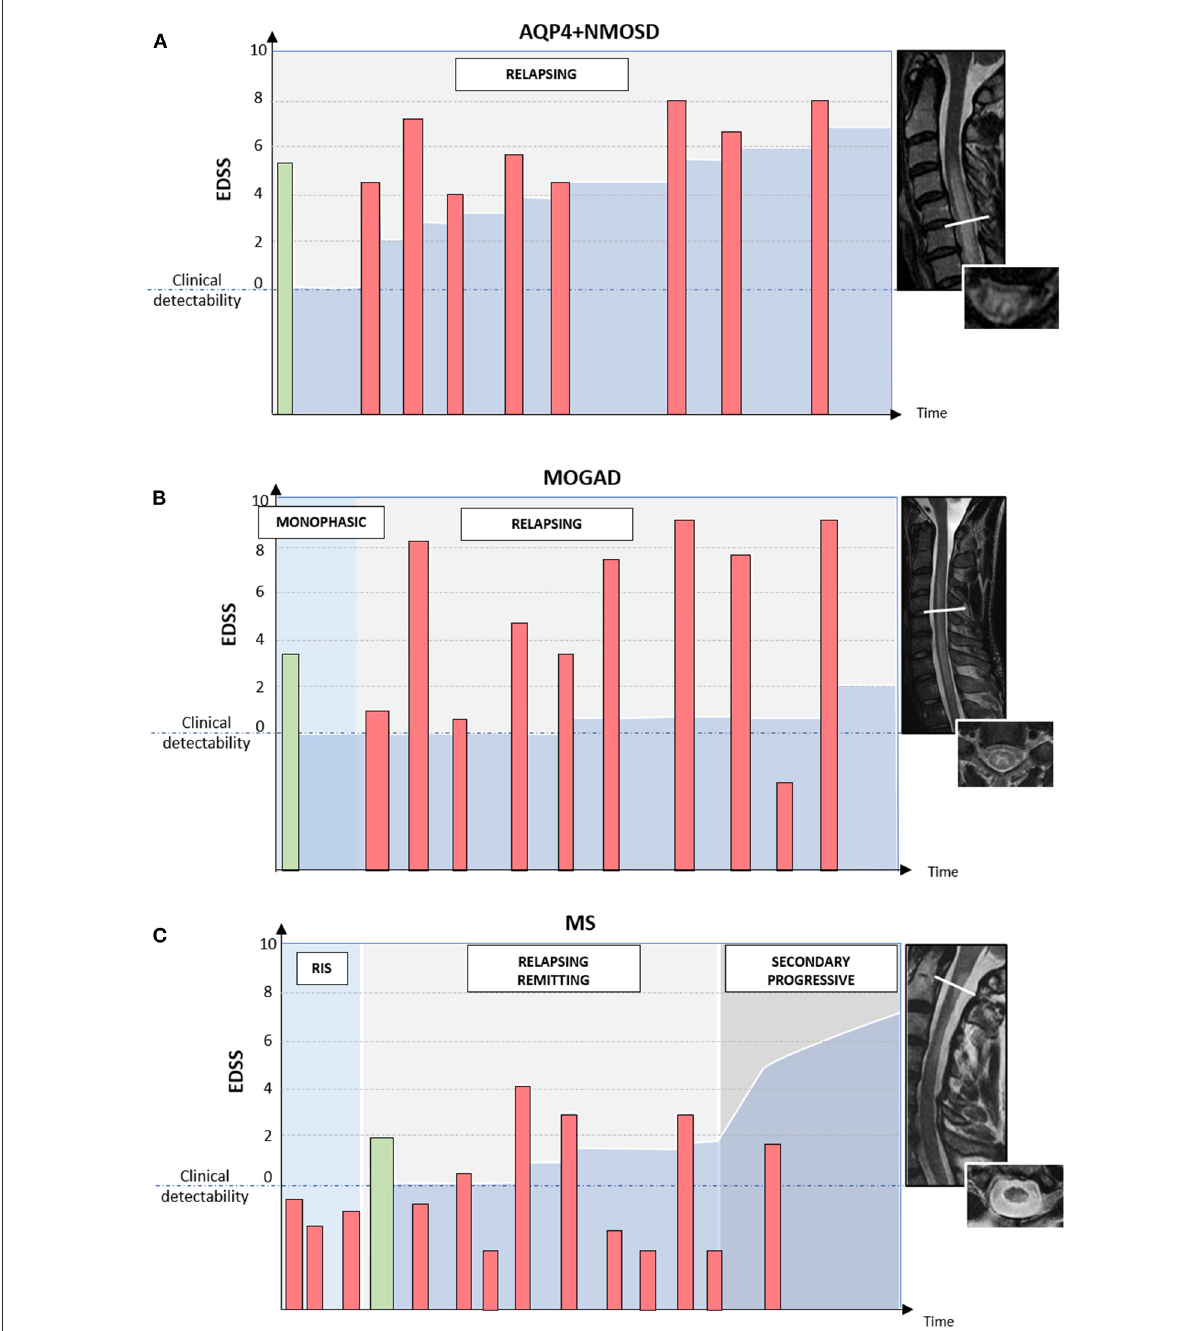
FIGURE4 Different disease courses and patterns of disability accrual in AQP4-IgG-positive neuromyelitis optica spectrum disorder (AQP4 + NMOSD), MOG-IgG-associated disease (MOGAD), and multiple sclerosis (MS). Red bars = disease relapses; green bars = first clinical attack; darker blue area in the bottom half of each diagram = accumulated disability. In patients with AQP4 + NMOSD (A) disease relapses are almost always clinically manifested with severe disability and often incomplete recovery between attacks. Disability accumulates in a stepwise fashion. In patients with MOGAD (B) disease attacks are similarly severe to those observed in NMOSD but post-attack recovery is generally complete or nearly complete. Long-term outcomes in MOGAD are often favorable with less disability accumulation (B) . Lastly, in patients with MS (C) disease relapses are typically of mild-moderate severity and often do not cross the threshold for clinical detectability. For this reason, the first clinical attack often occurs in patients with MRI evidence of prior asymptomatic lesions. When these lesions are detected incidentally during the diagnostic workup for other disorders (e.g., headache), before the presenting MS attack, a radiologically isolated syndrome (RIS) can be diagnosed. When clinically manifested, MS attacks tend to result in complete or nearly complete clinical recovery in most cases (relapsing-remitting MS); while progressive disability accumulation can be seen in a minority of cases either from disease onset (primary progressive MS) or after an initially relapsing-remitting course (secondary progressive MS). Progressive disability generally occurs in the form of progressive motor impairment in MS, which often coincides with the development of focally atrophic lesions in the spinal cord lateral